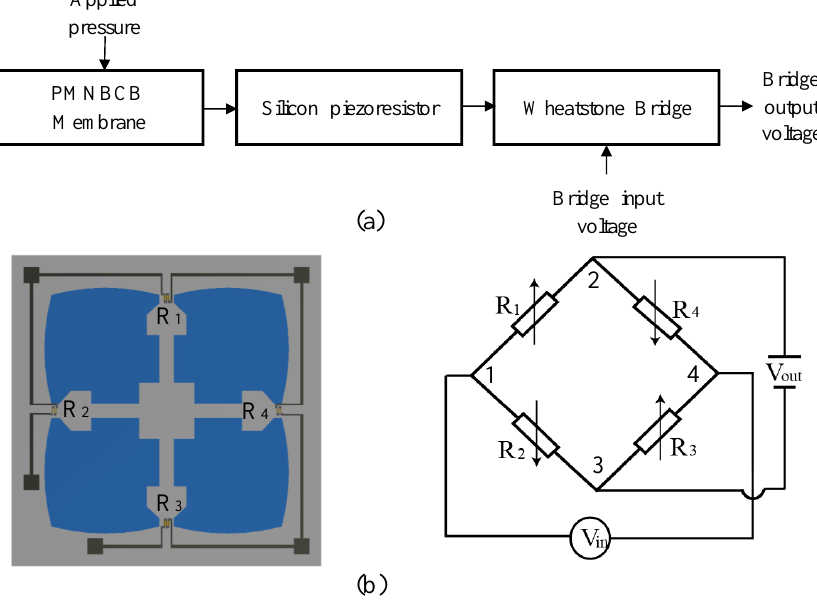
Figure 2. ( a ) Working principle of the piezoresistive pressure sensor; ( b ) four-petal membrane combined with narrow beams and a center boss (PMNBCB) membrane and Wheatstone